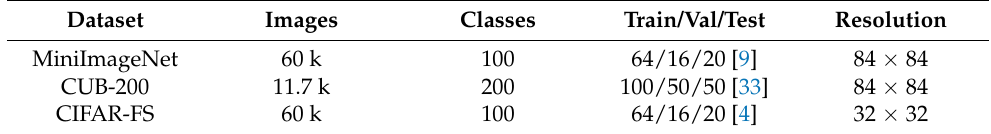
Table 5. Details for few-shot dataset benchmarks.